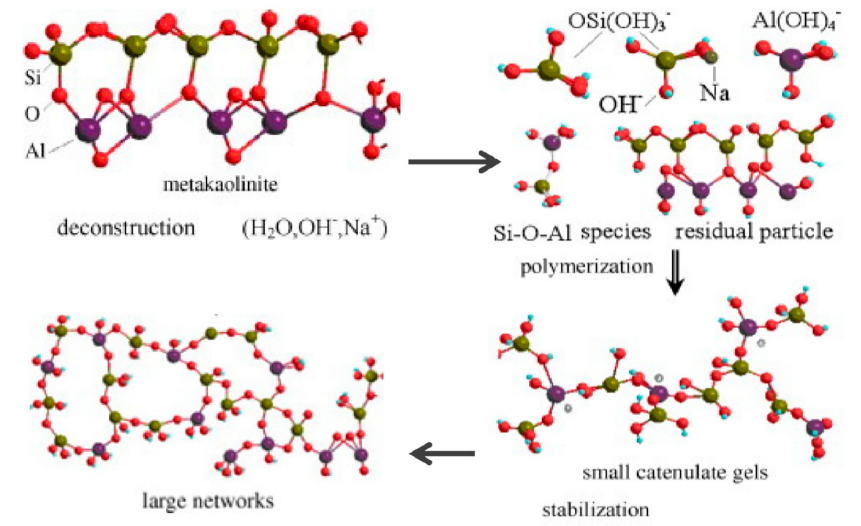
Figure 1. Reaction mechanism of geopolymerisation with metal kaolinite process [8,11]. Sodium hydroxide (NaOH) and sodium silicate (Na 2 SiO 3 , water glass) are